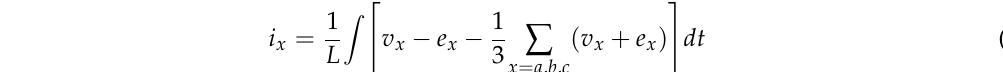
Table 2. Specifications of the prototype for simulation.